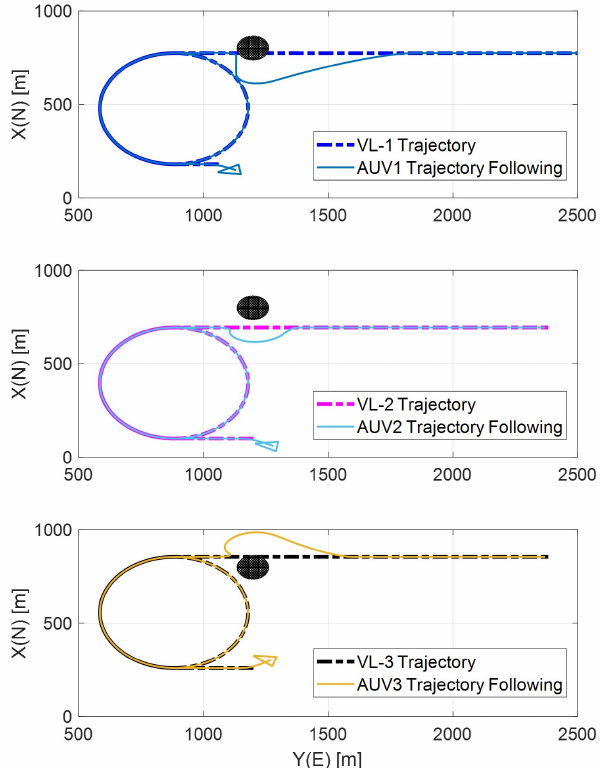
Figure 5. Each vehicle’s trajectory following with obstacle avoidance on the horizontal